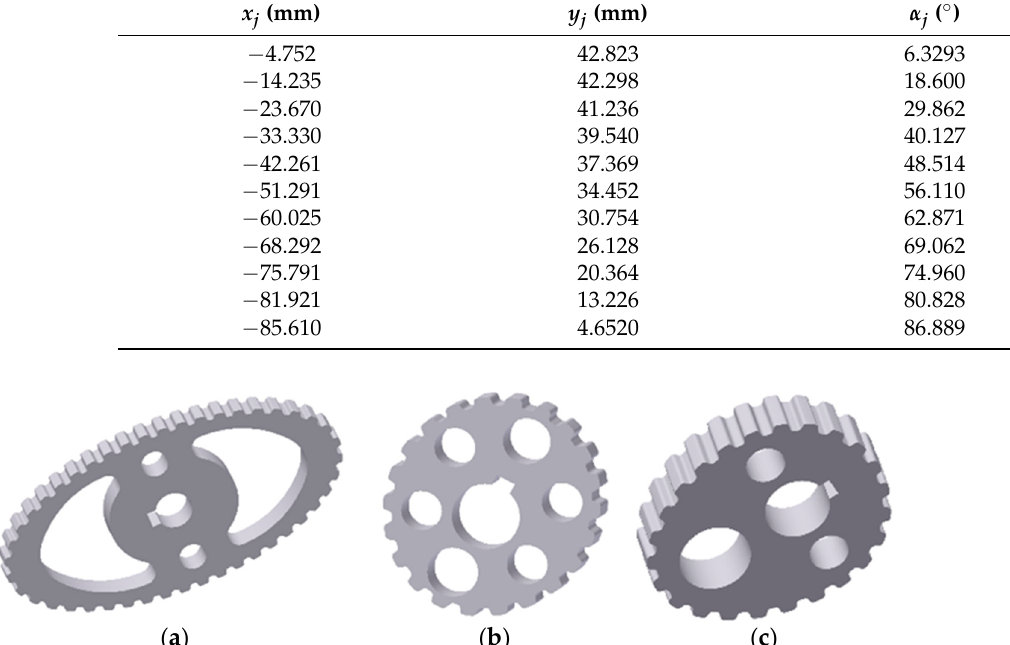
Figure 3. Non-circular wheels of non-rotating gears; ( a ) a wheel with an ellipse-shaped envelope, ( b ) a wheel with an envelope close to a circle, ( c ) a non-circular irregular wheel.